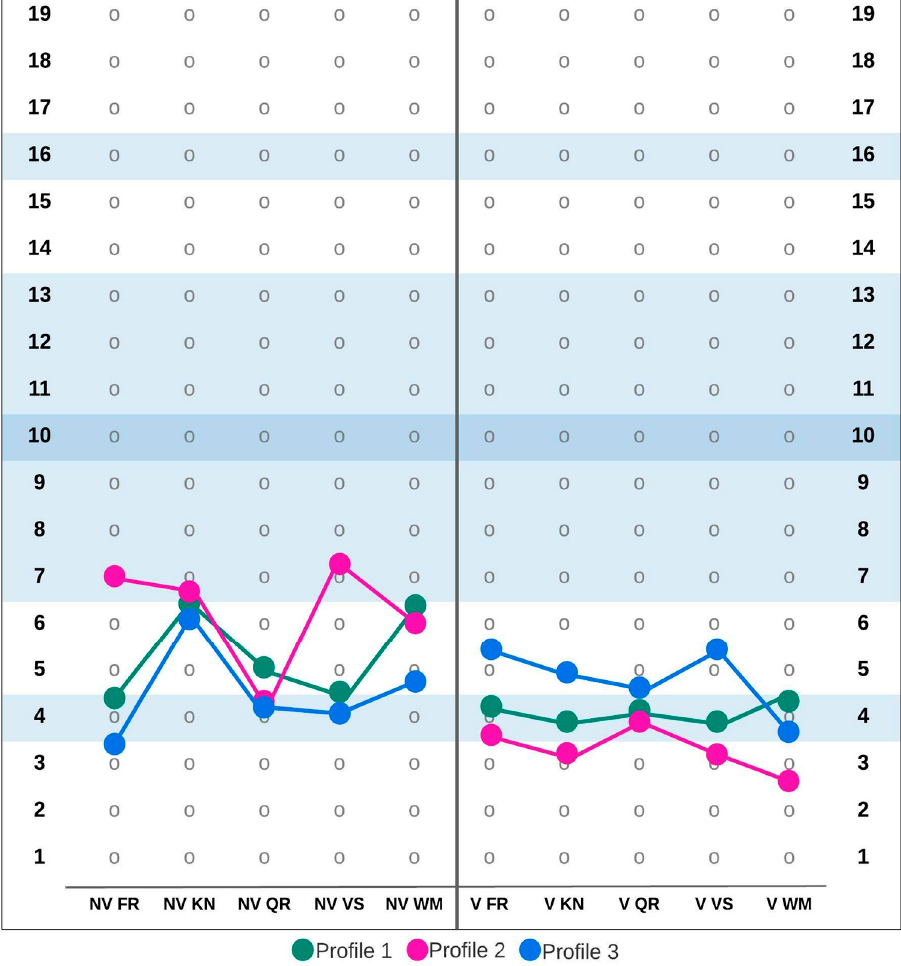
Figure 1. Mild intellectual disability cognitive profiles in the 7;00–9;11 age group. Abbreviations: NV FR—Nonverbal Fluid Reasoning, NV KN—Nonverbal Knowledge, NV QR—Nonverbal Quantitative Reasoning, NV VS—Nonverbal Visual-Spatial Processing, NV WM—Nonverbal Working Memory, V FR—Verbal Fluid Reasoning, V KN—Verbal Knowledge, V QR—Verbal Quantitative Reasoning, V VS—Verbal Visual-Spatial Processing, V WM—Verbal Working